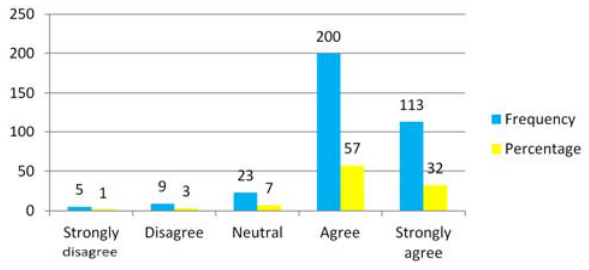
Fig. 3. Entrepreneurial perceptions of the respondents